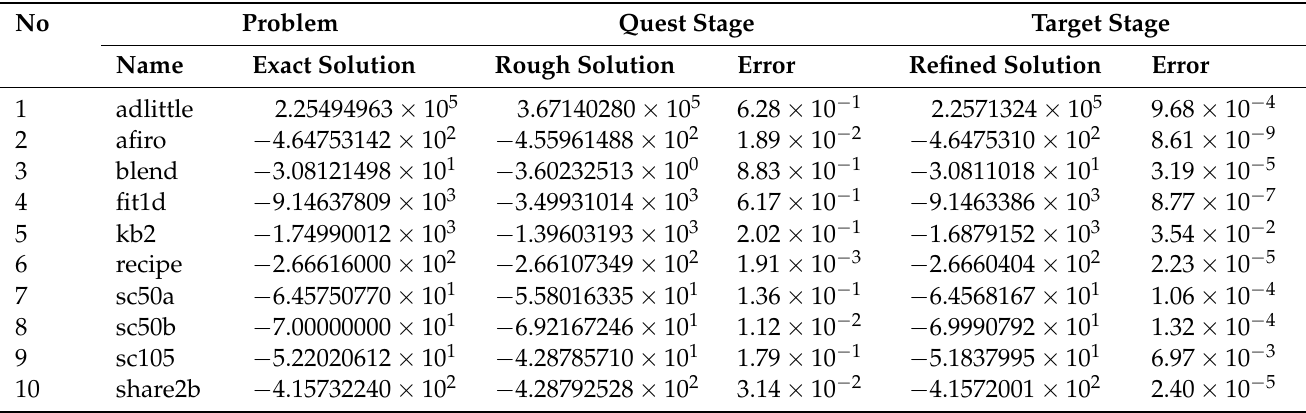
Table 2. Applying the apex method to the Netlib-LP